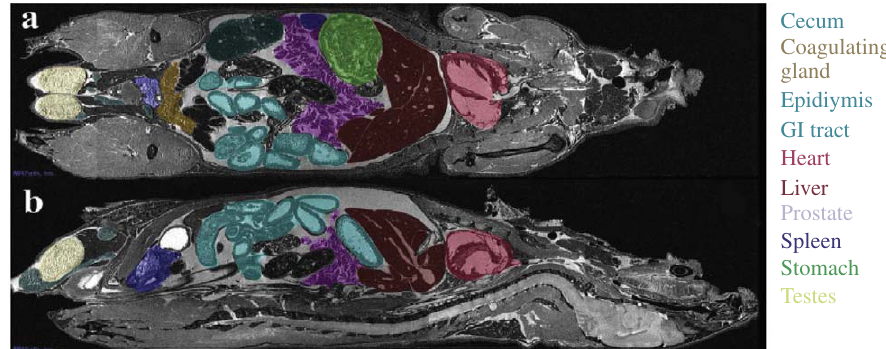
Fig. 5. Whole body imaging of a fixed-perfused mouse specimen at 50 (cid:1) m resolution allows the identification of major organs, as well as the assessment of microstructural properties. Reprinted with permission from